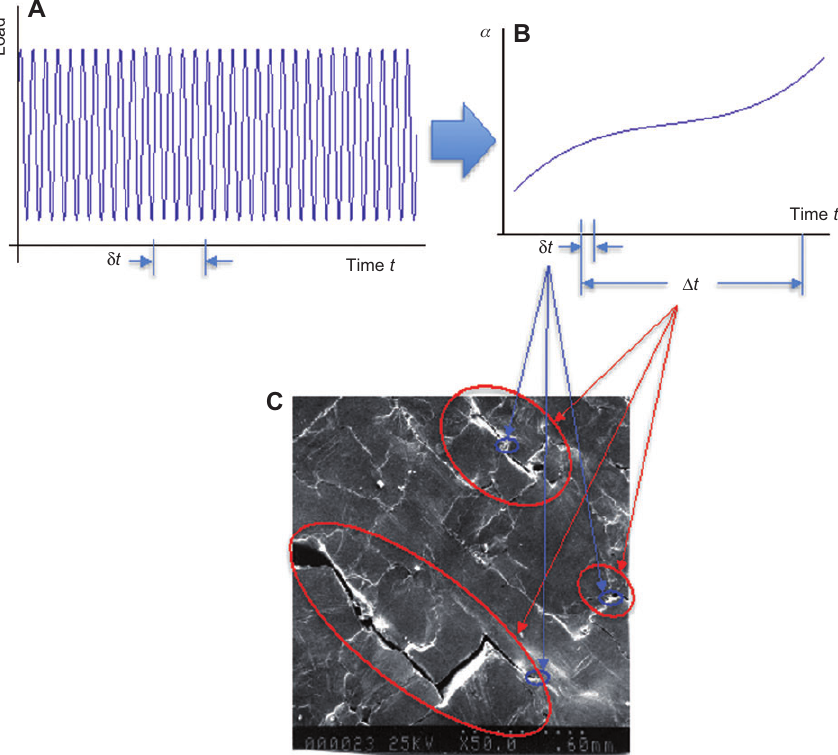
Figure 1 Time scales and example of structural changes during fatigue loading of a polycrystalline material. (A) Schematic of the load vs. time during fatigue. (B) Schematic of corresponding changes in material state variables realized through a and short time scale δ t and large time scale Δ t . (C) Typical electron microscopy image of a fatigue-damaged polycrystalline steel, and example changes in state variables over δ t (inside the blue ellipses) and Δ t (inside the red